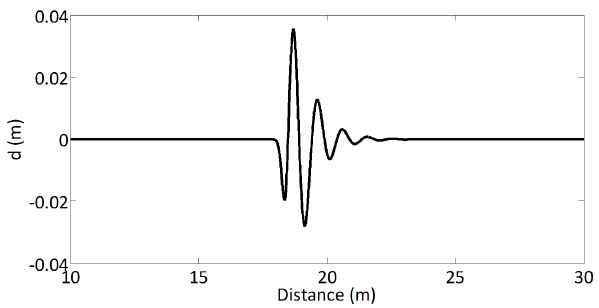
Figure 13. Time Domain Simulation: Control Mass